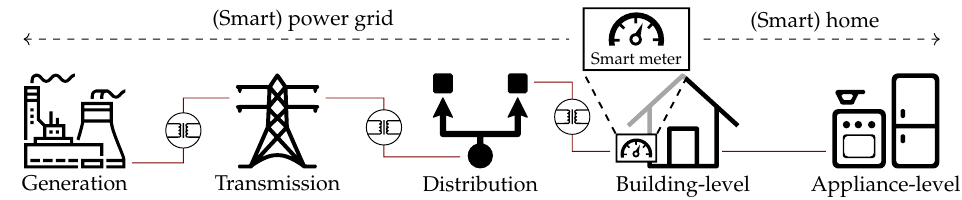
Figure 1. Location of smart meters within the electrical power grid (icons by Icon Fonts; CC BY 3.0).